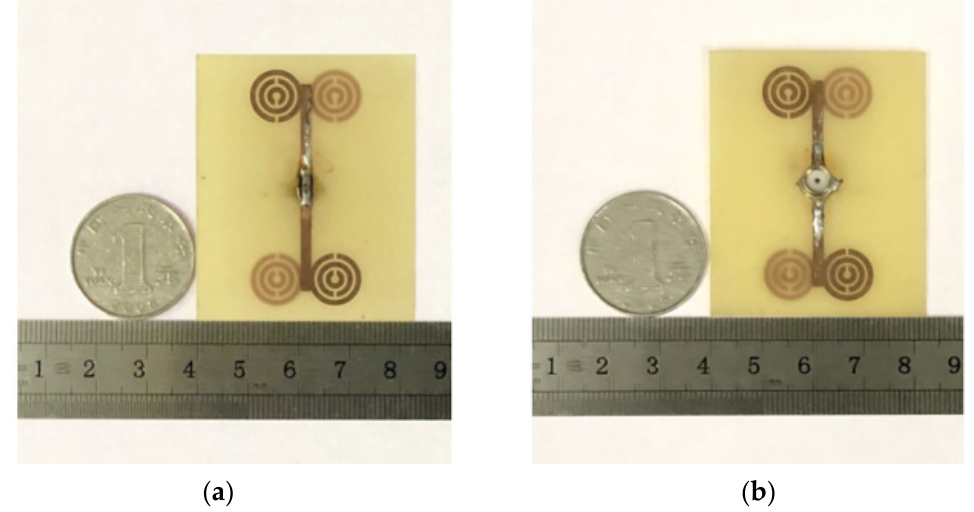
Figure 7. Fabricated antenna model: ( a ) the top view; ( b ) the bottom view.